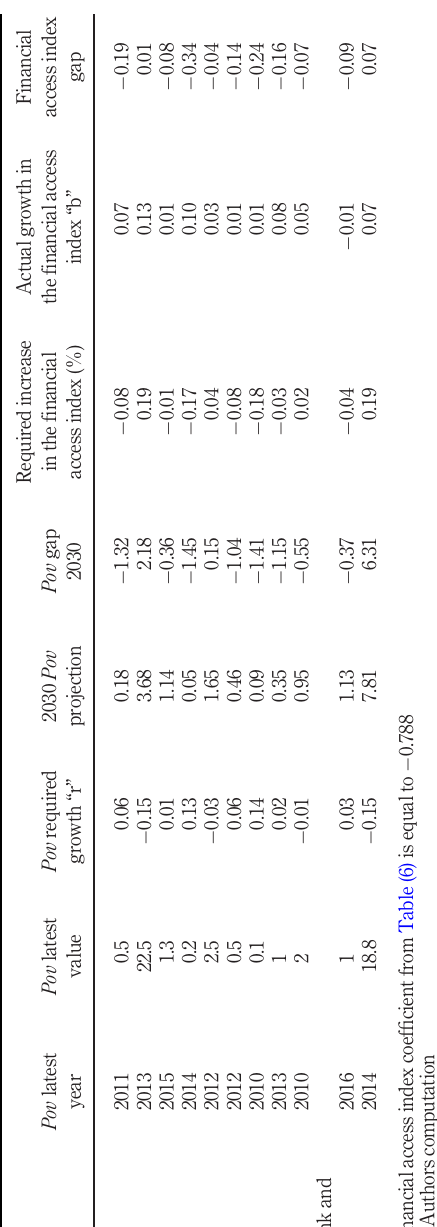
Table A8. Extreme poverty and financial access gap analysis in MENA region – assessment against the 1.5% poverty